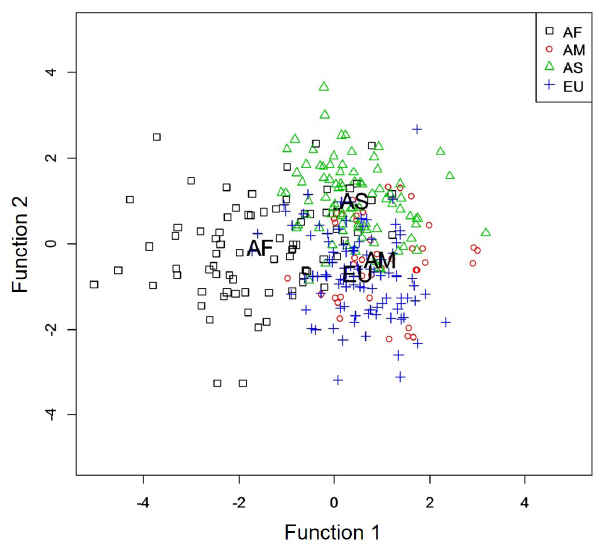
Figure 1. Territorial map of discriminant functions 1 and 2. AF, Afri - ca; AM, America; AS, Asia; EU, Europe. Abbreviations plotted inside the figure indicate group